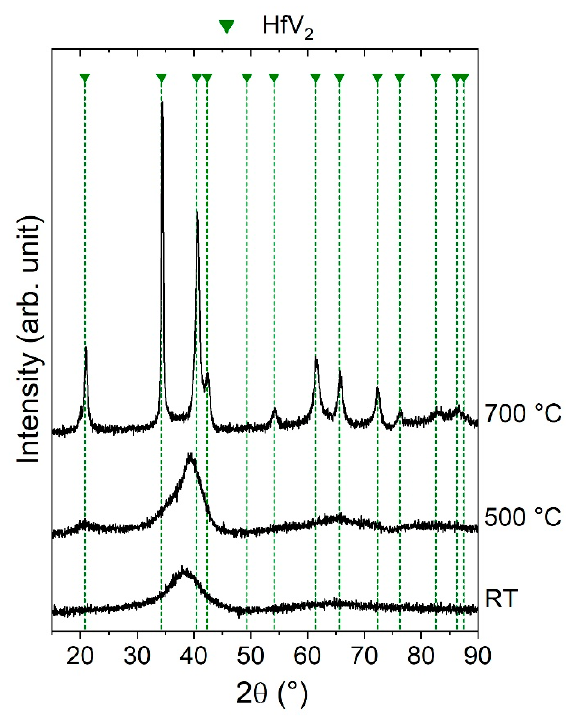
Figure 2. X-ray di ff ractograms of stoichiometric (V / Hf = 2.0) Hf-V samples synthesized without Figure 2. X-ray diffractograms of stoichiometric (V/Hf = 2.0) Hf–V samples synthesized without intentional heating (RT) and at synthesis temperatures of 500 and 700 ◦ intentional heating (RT) and at synthesis temperatures of 500 and 700 °C.